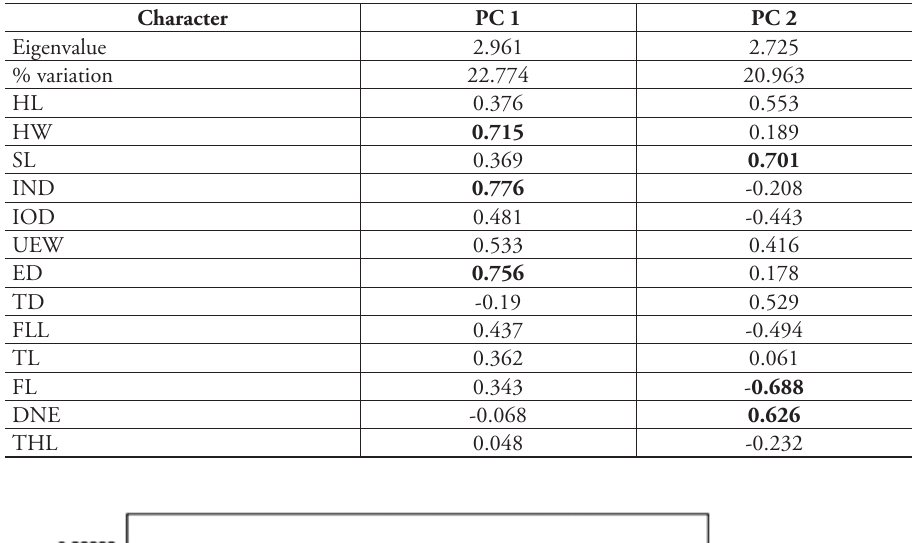
Table 3. Factor loadings of the first two principal components of 13 size-adjusted morphometric charac- teristics of males of K. lenquanensis sp. n., K. idiootocus , K. odontotarsus , and K. bisacculus . Absolute values of loading greater than 0.60 in boldface. Abbreviations defined in text.